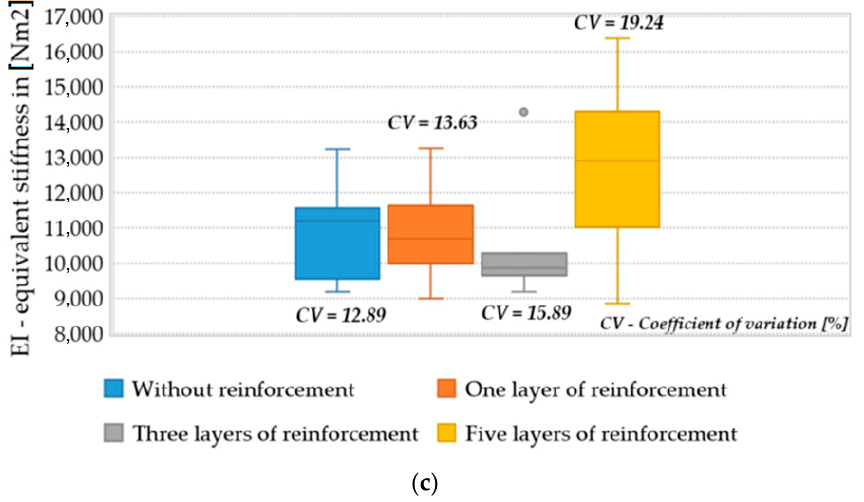
Figure 6. Box and whisker plots for ( a ) maximum destructive force; ( b ) displacements under destructive force; ( c ) equivalent stiffness for the range 2–6 mm. Table 3. Comparison of load-bearing capacities for the beams in the various